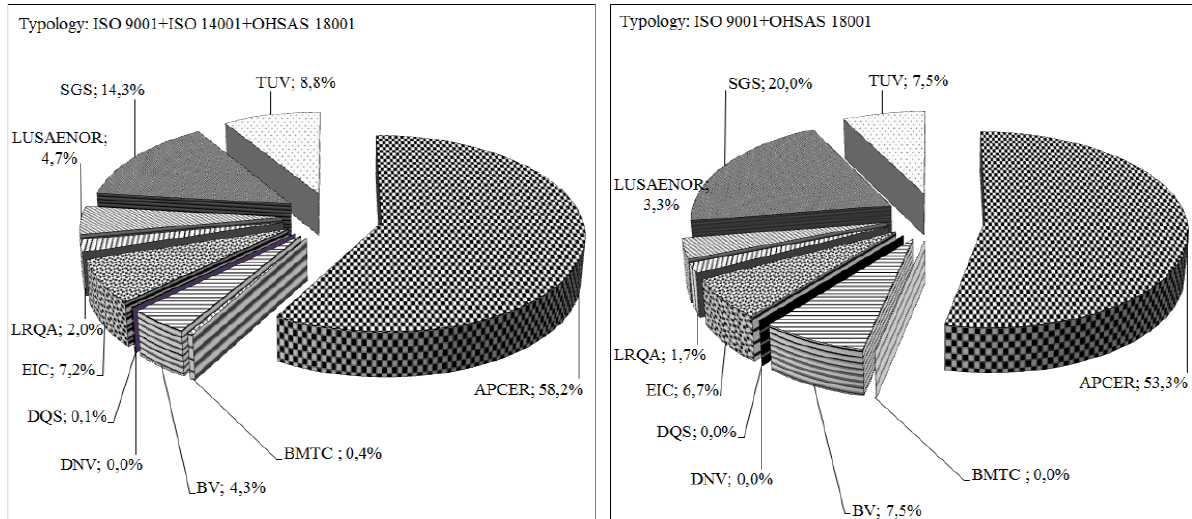
Figure 9. Relevant certification bodies involved with the ISO 9001+OHSAS 18001 integrated typology.